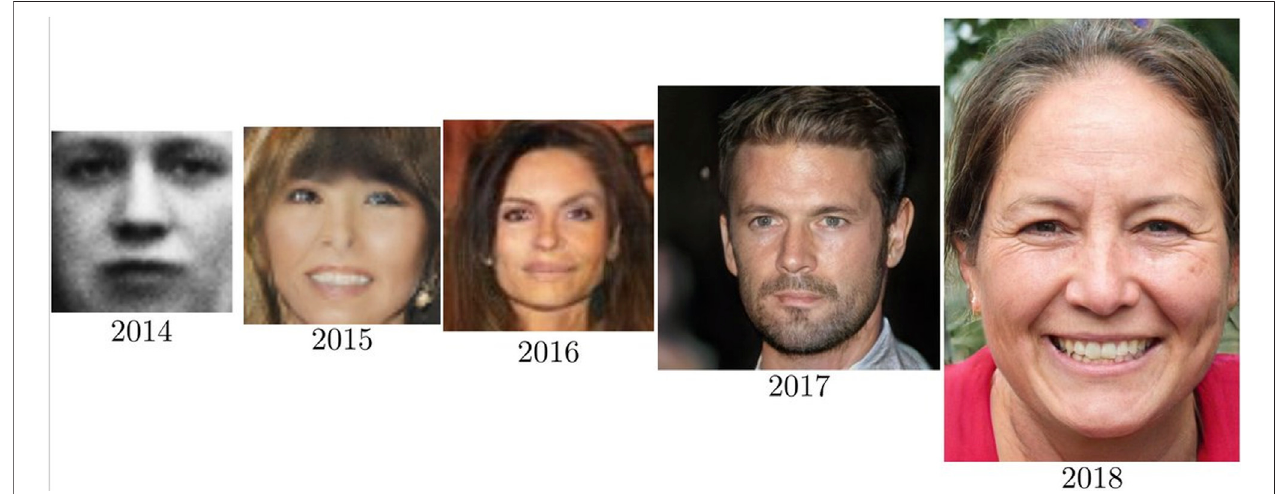
FIGURE 1 | Progress in synthetic face generation due to advances in self-supervised generative AI methods (Source: Tweet by Ian Goodfellow).